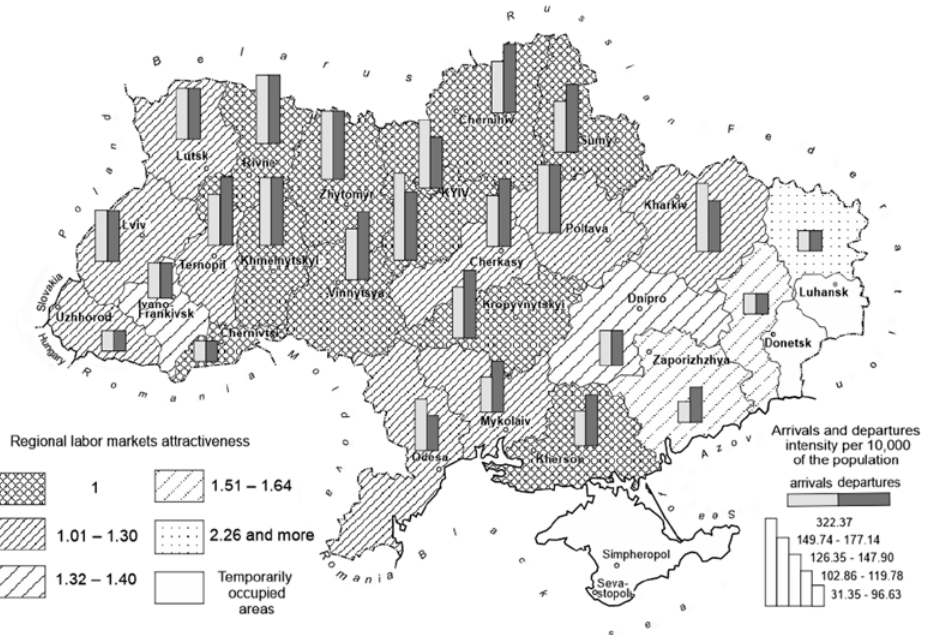
Figure 5. Migration attractiveness of Ukrainian regions: internal migration activity of the population in terms of the labor market and employment development in